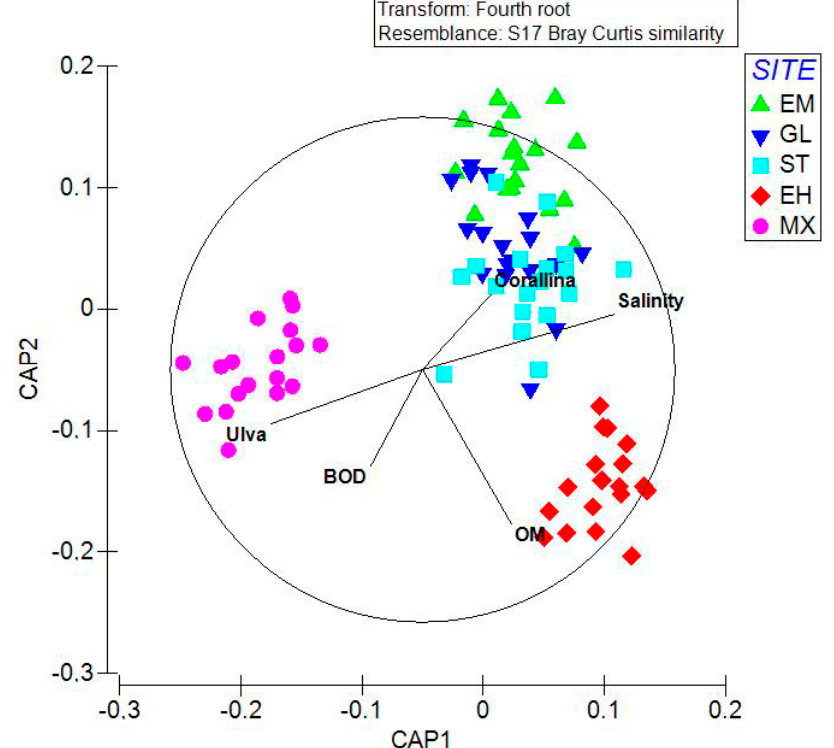
Figure 3. Canonical analysis of the principal coordinates (CAP). Correlation (Pearson) of the environmental variables, including algal cover, with the canonical axes is also reported. BOD, biochemical oxygen demand; OM, organic matter.